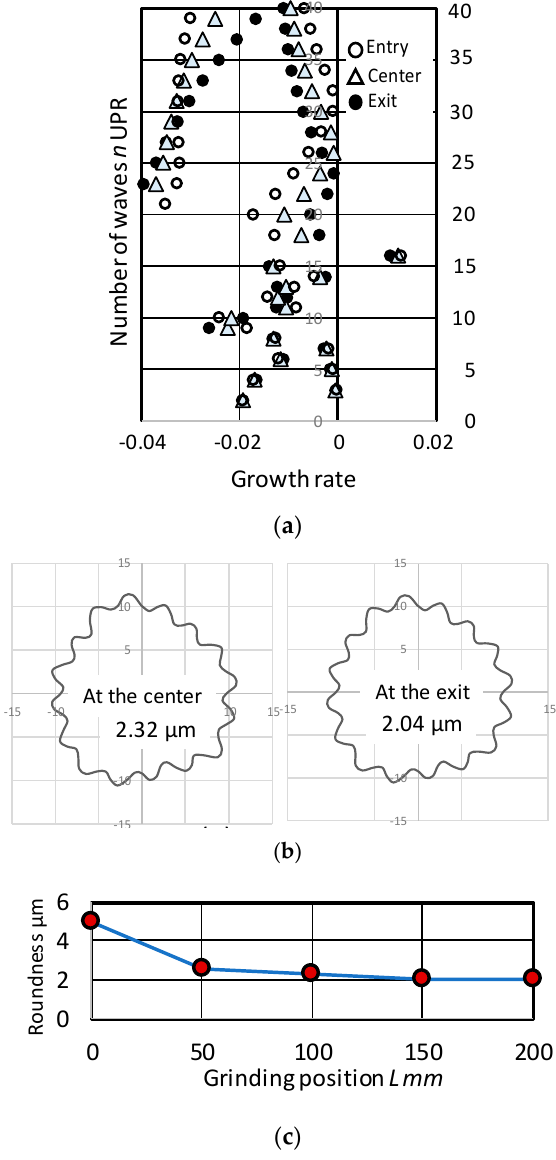
Figure 8. Simulation II: Unstable process, RSI = 7.79. ( a ) Characteristics roots; ( b ) Roundness; ( c ) Progress of roundness.